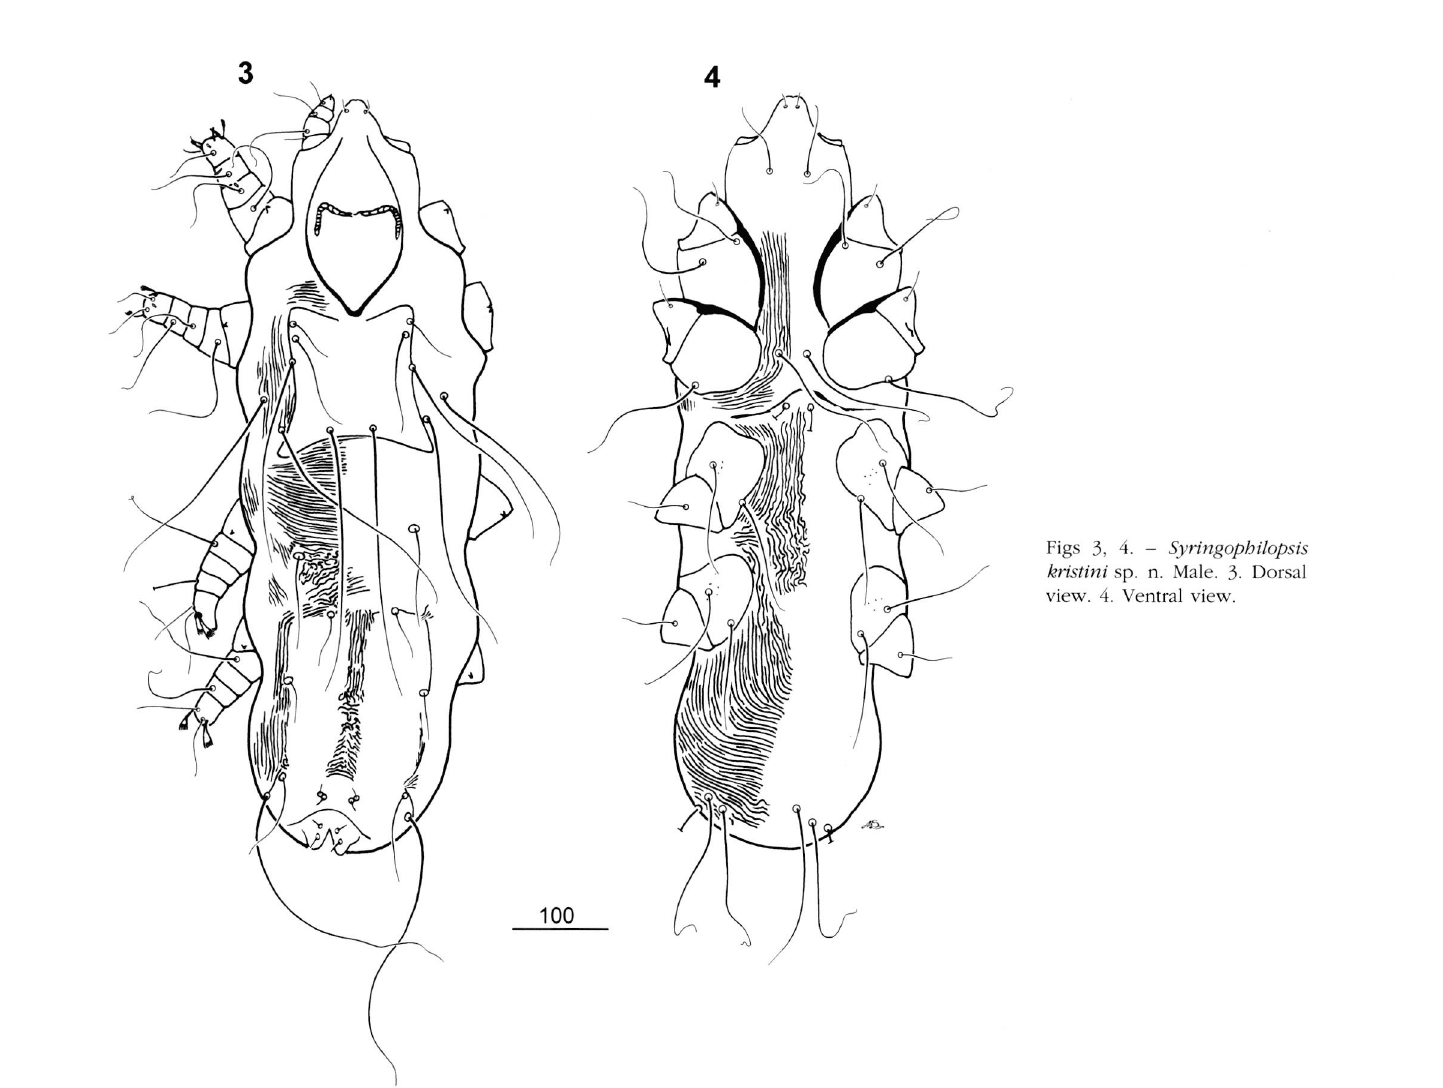
Figs 3, 4. - Syringophilopsis kristini sp. n. Maie. 3- Dorsal view. 4. Ventral